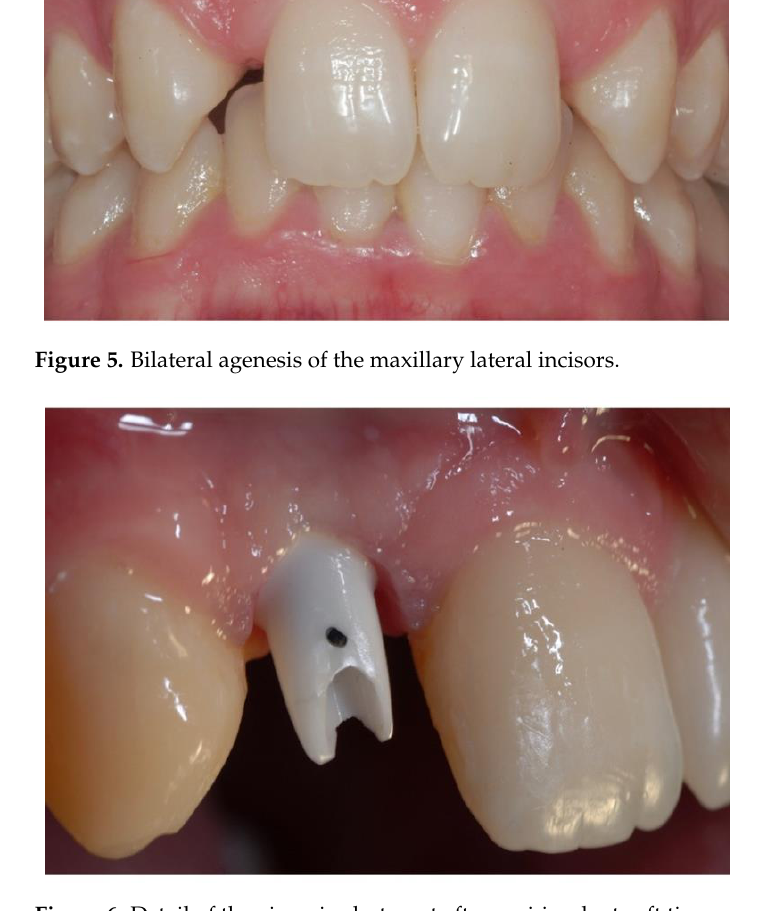
Figure 6. Detail of the zirconia abutment after peri-implant soft tissues conditioning in position 12.